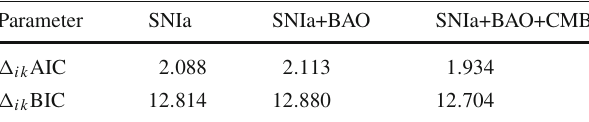
Table 3 Comparative analysis between the model RRG + RGE (with three free parameters: (cid:9) 0 m , ν and b ) and the case of ν = b = 0 ( (cid:3) CDM with two free parameters)